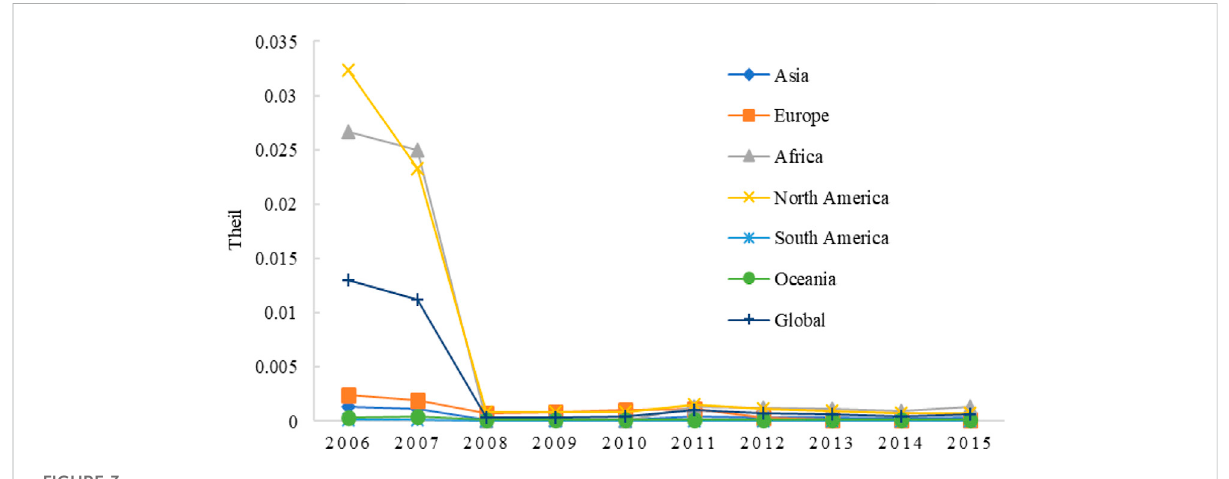
FIGURE 3 Global and six continents Theil index